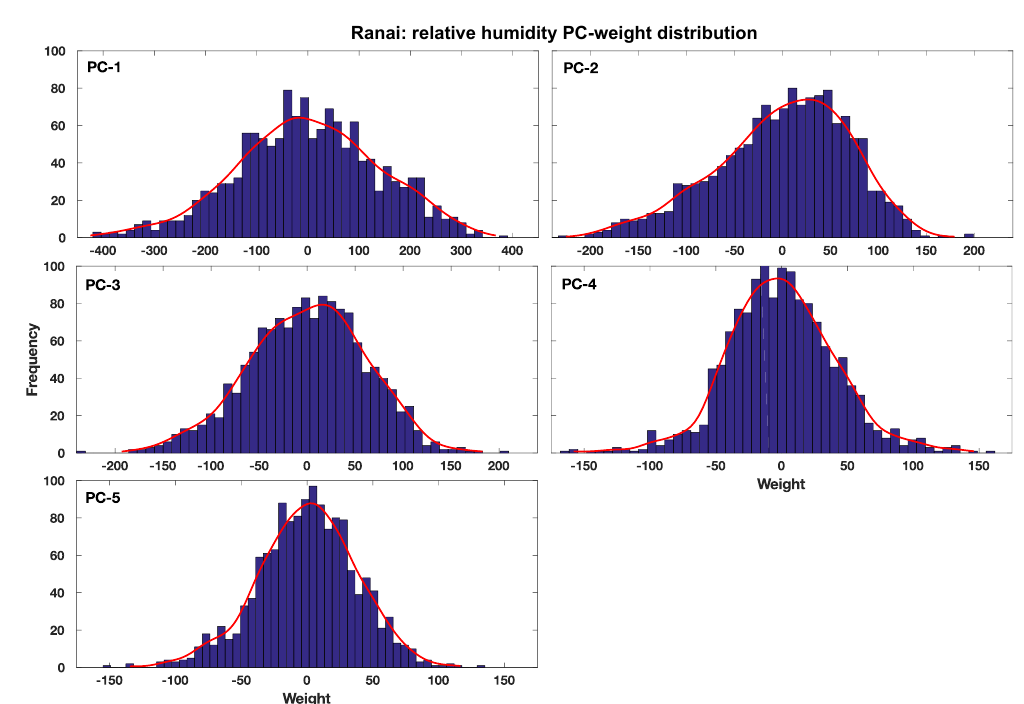
Figure 3. Histograms of the relative humidity PC weights for Ranai in blue, with distribution fits in red. The original descriptive statistics (Fig. 2) showed signs of skewness for this variable. Because the original input data were not standardized, the PCA algorithm retains the inherent skewness, which is observable in PC-2, PC-3, and